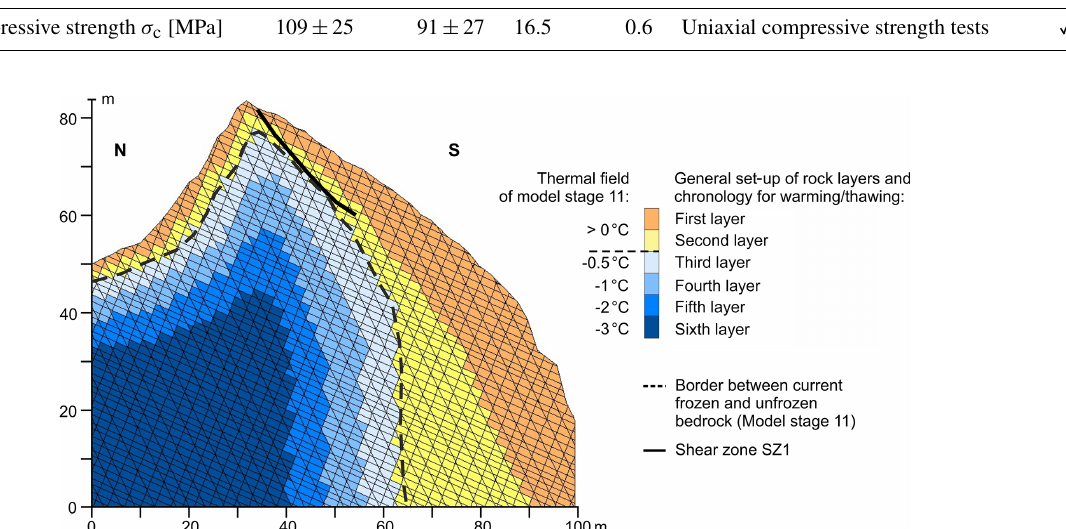
Figure 5. Spatial warming/thawing pattern for the numerical model of the Zugspitze summit crest. For each warming/thawing step, the six rock layers (coloured areas) are assigned an individual temperature with a characteristic set of mechanical parameters. Warming or thawing proceeds from the outside to the inside of the crest. The dashed black line marks the current boundary between frozen and unfrozen rock, derived in Sect. 2.4. The presented thermal field is estimated and refers to model stage 11 in Table 6 (current state of permafrost distribution in the